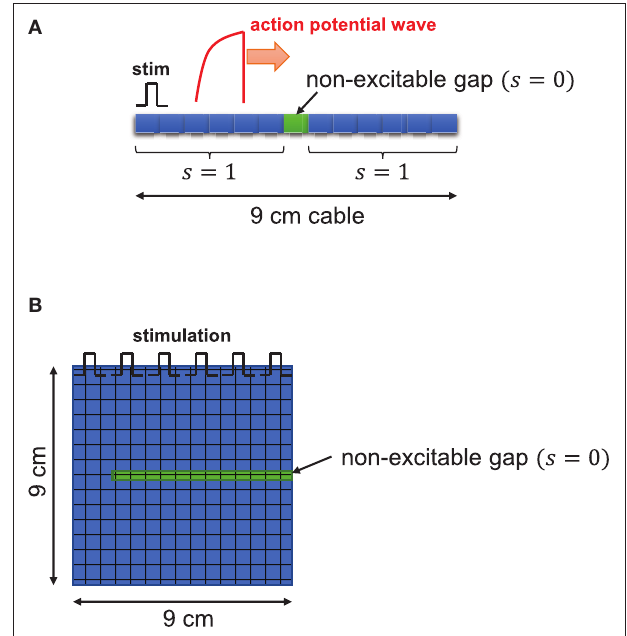
FIGURE 1 | Schematic illustration. One dimensional tissue was paced with stimuli applied uniformly at the left edge of the tissue. The cable length is 9cm. (A) In the cable, s(x), function of excitability with respect to position in tissue, is 1 for excitable cells and 0 for non-excitable cells. (B) In two-dimensional tissue, the non-excitable gap was inserted in the middle of the